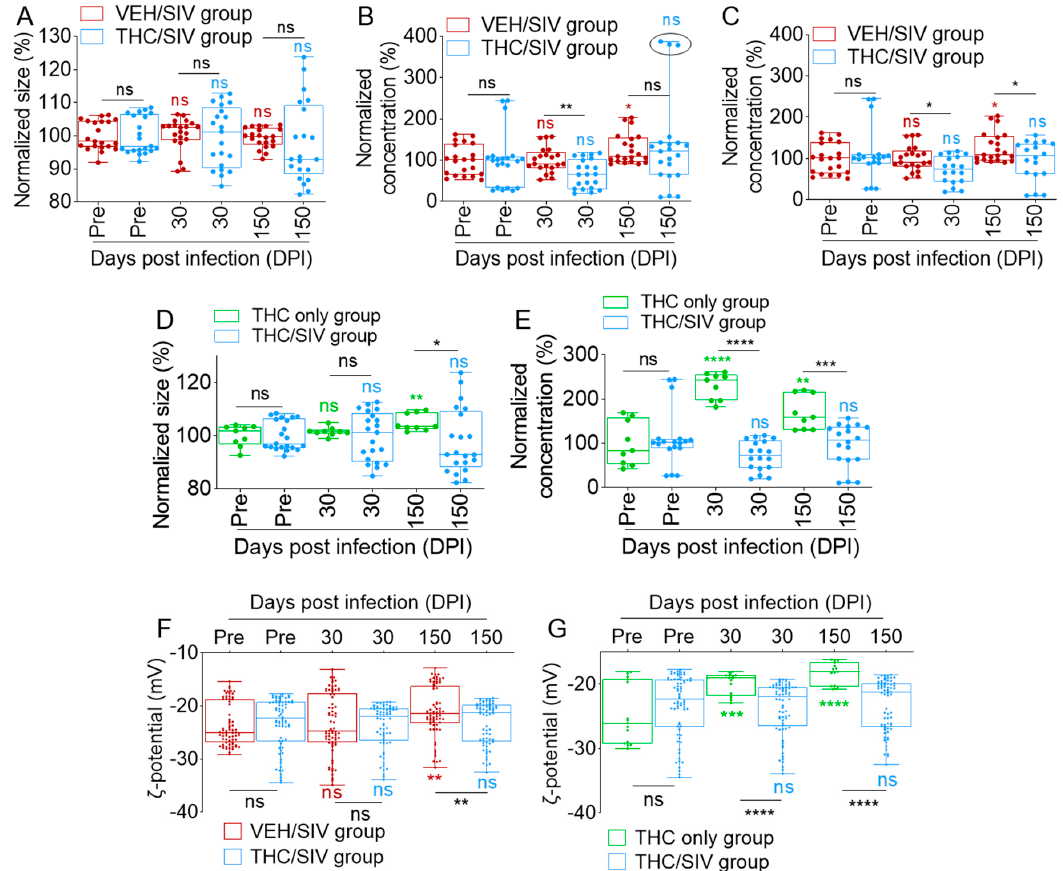
Figure 2. The effects of SIV infection and THC treatment of SIV ‐ infected RMs on the physical properties of BEVs: ( A ) adjusted BEV size comparison between VEH/SIV and THC/SIV groups. ( B ) Adjusted BEV concentration comparison between the VEH/SIV and THC/SIV groups. ( C ) Adjusted BEV concentration comparison between the VEH/SIV and THC/SIV groups without the outlier THC/SIV RMs at 150 DPI (circle in B). ( D ) Adjusted BEV size comparison between the THC/SIV and THC only groups. ( E ) Adjusted BEV concentration comparison between the THC/SIV and THC only groups. ( F ) BEV ζ potential comparison between the VEH/SIV and THC/SIV groups. ( G ) BEV ζ potential comparison between the THC/SIV and THC only groups. For adjustments, the 30 and 150 DPI data were normalized according to respective pre ‐ SIV data. Ordinary one ‐ way ANOVA (Brown–Forsythe and Bartlett tests, with Sidak’s multiple comparisons test) was used to determine the statistical significance within the group. Binary Student’s t tests (Welch’s correction) were used to determine significant differences between groups for each of the time points in each group. **** p < 0.001, *** p < 0.005, ** p < 0.01, * p < 0.05, and ns = non ‐ significant.